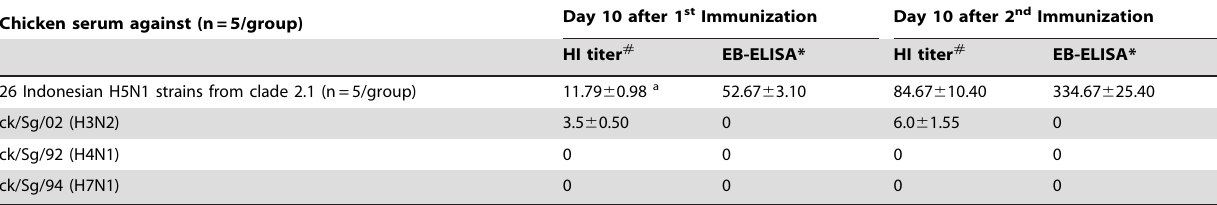
Chicken serum against (n=5/group)